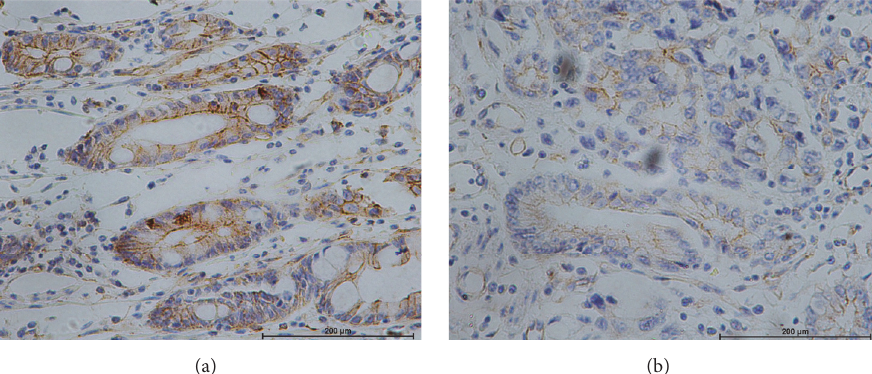
Figure 2: The protein expression of iNampt in these EGA specimens was analyzed by immunohistochemical staining ( × 400). iNampt expression was significantly upregulated in these tumors from obese patients, especially visceral obesity (a), compared to those nonobese patients (b) (7.31 ± 3.04 versus 4.34 ± 2.64, 𝑃 < 0.001